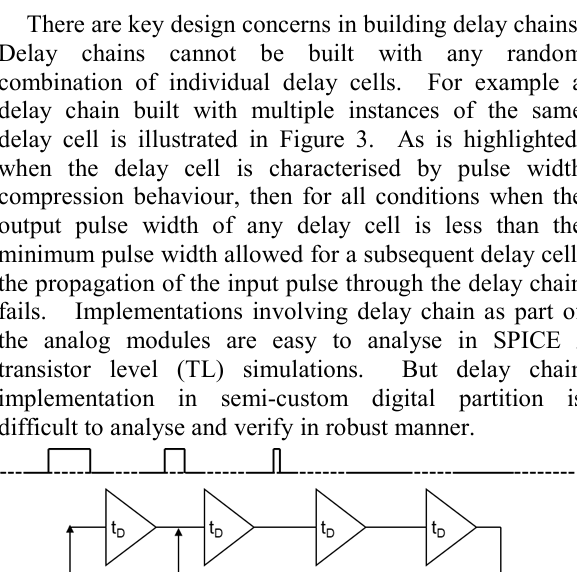
There are key design concerns in building delay chains.